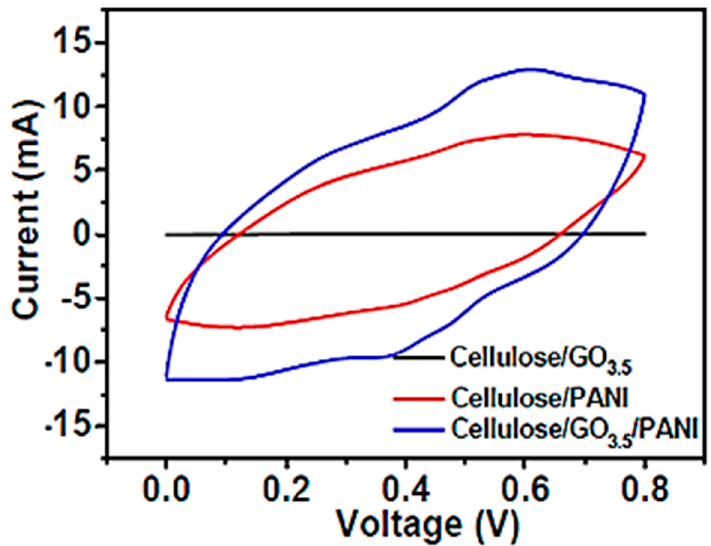
Figure 15. Typical cyclic voltammogram (CV) curves of cellulose/polyaniline, cellulose/graphene oxide, and cellulose/graphene oxide/polyaniline electrodes at 50 mV/s. [128]. Reproduced with permission from MDPI.